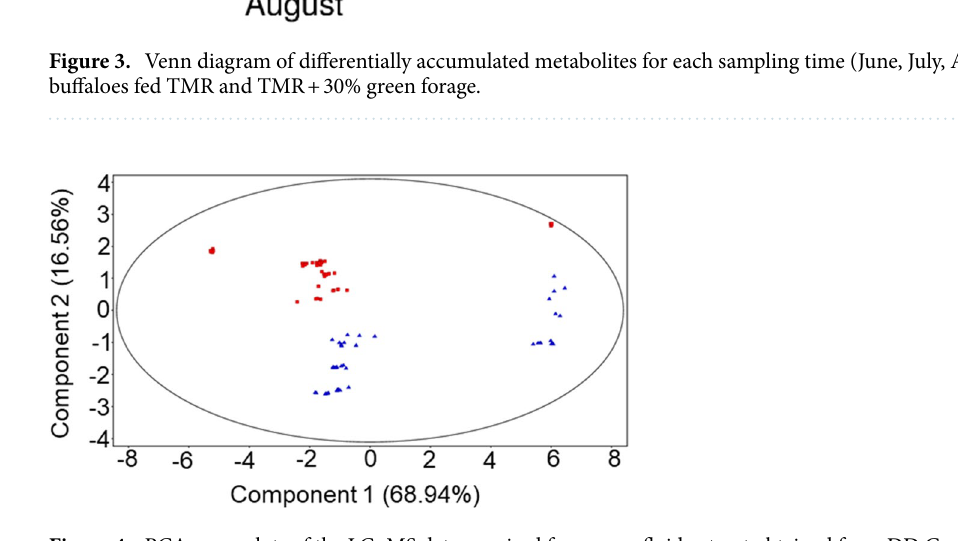
Figure 4. PCA score plots of the LC–MS data acquired for rumen fluid extract obtained from DD Group fed a total mixed ratio (TMR) (red squares) and ZG Group fed TMR + 30% of green forage (blue triangles). PC1 accounts for 68.94% and PC2 16.56% of total variance.